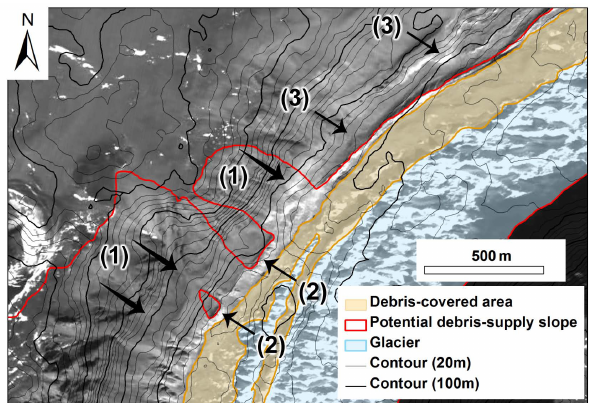
Fig. 3. Visual interpretation of potential debris-supply slopes on a PRISM image (location indicated in Fig. 1). (1) Traces or scars show the possibility of debris supply. (2) Small hills identified by shadings and (3) depressions outside lateral moraine may prevent debris supply.